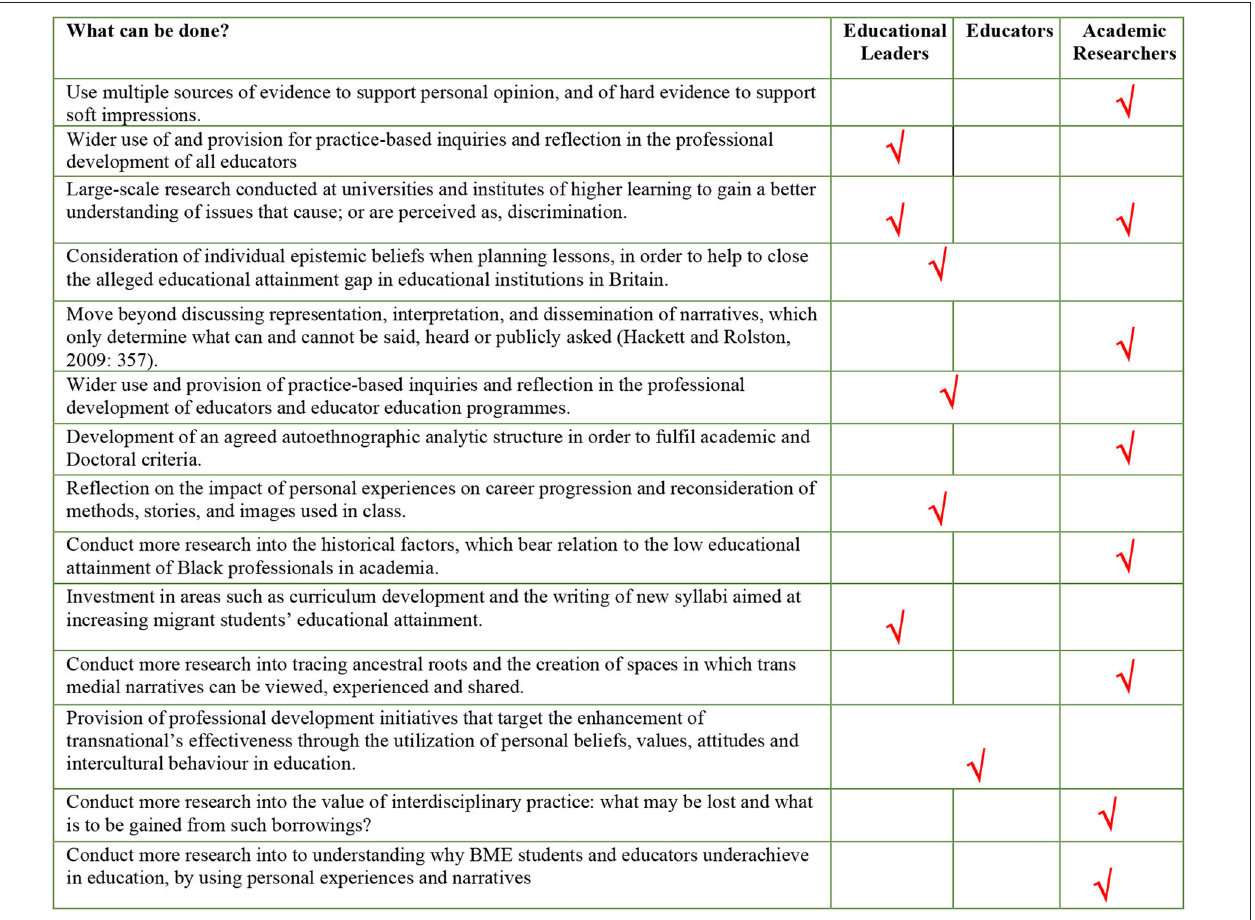
FIGURE 2 | Learning from the story (Source: Kappert,